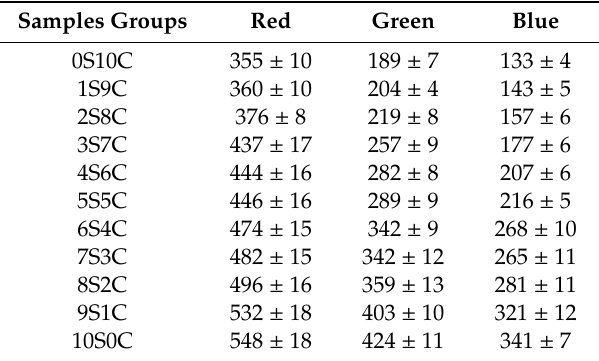
Table 5. Color coordinates of the samples families in the primary colors (red, green, and blue). Samples